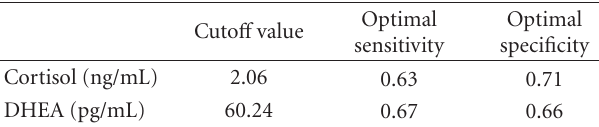
Table 5: Cuto ff values for cortisol and DHEA in saliva for optimal sensitivity and specificity obtained from ROC curve for PD levels in never-smokers.